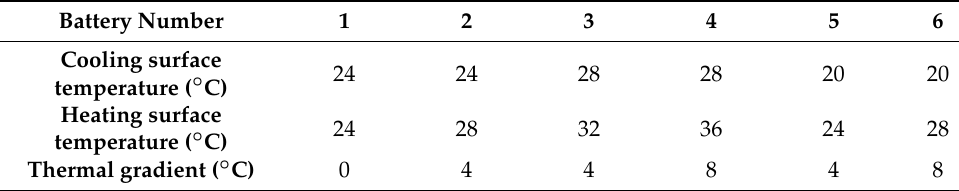
Table 1. Cell number and corresponding thermal gradient.